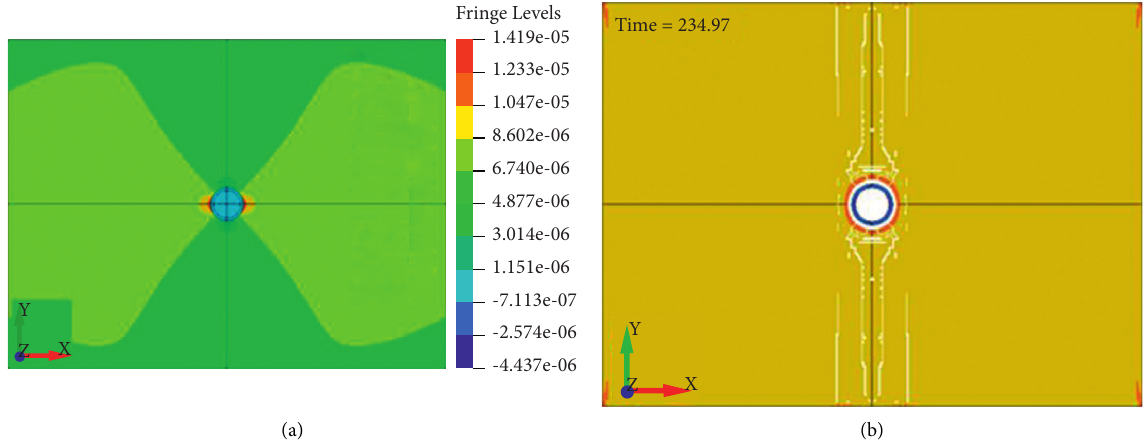
Figure 13: The distribution of stress and crack propagation around a blast hole under unidirectional in situ stress (Case IV: P 1 � 2.0MPa). (a) Distribution of tensile and compressive stress. (b) Two reflective tensile